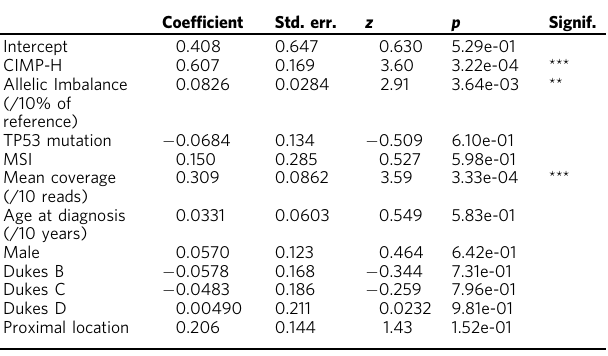
Table 2 Multiple linear regression model for log insertion counts